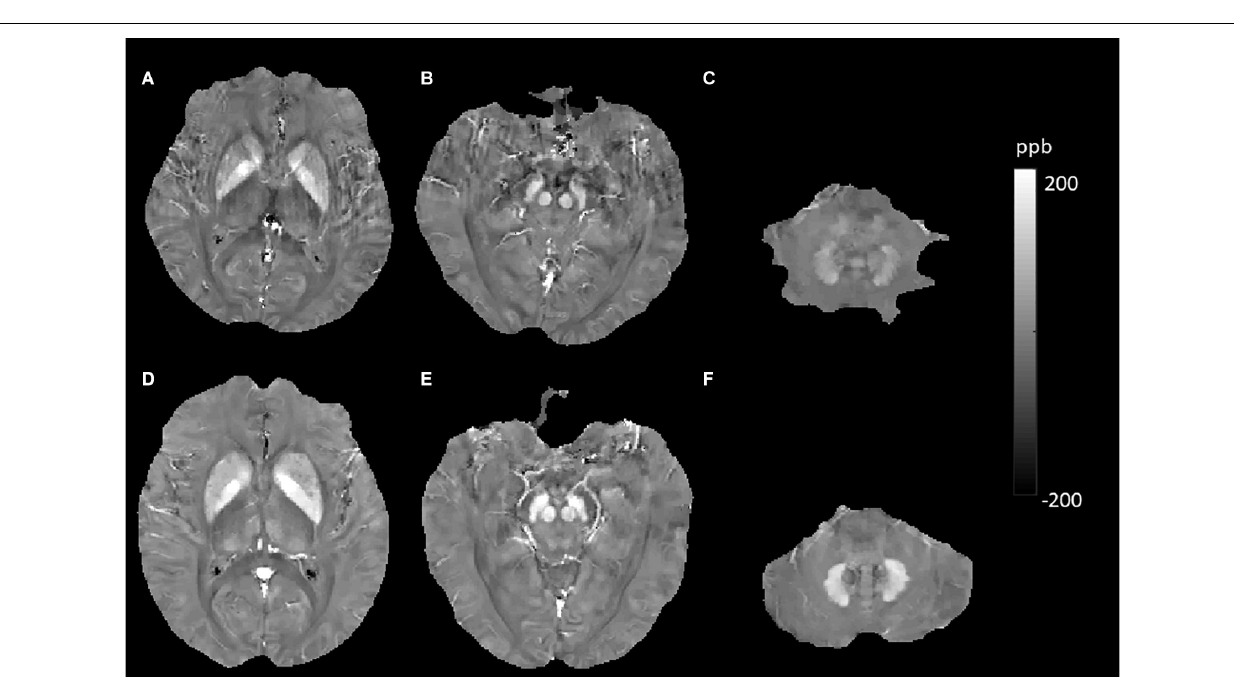
Frontiers in Aging Neuroscience |